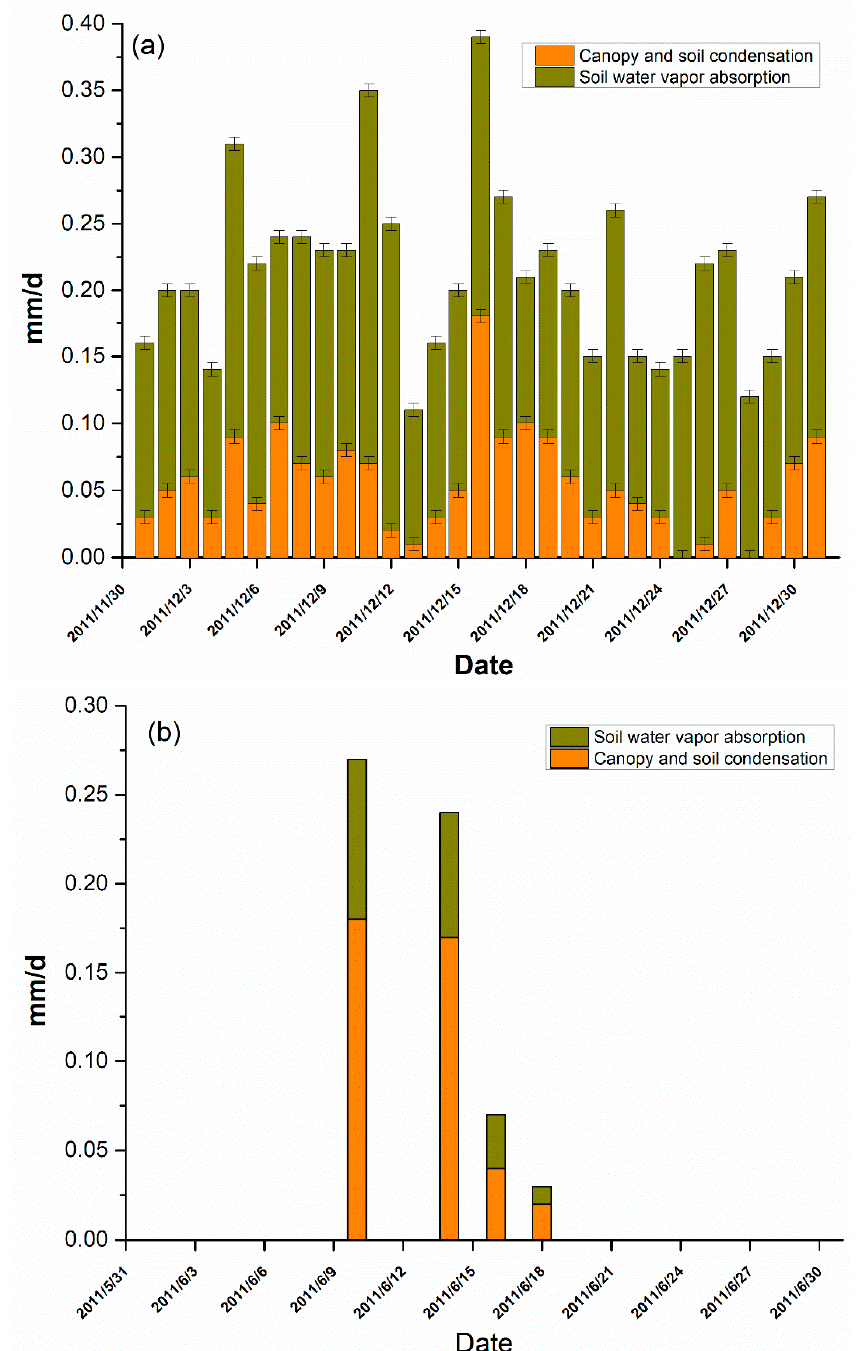
Figure 12. Quantitative variations among soil water vapor absorption and canopy and soil condensation on the basis of the measured soil water content at 0–5 cm, soil surface temperature, and calculated dew point temperature. Daily data was recorded from 1–30 June ( b ) and from 1–31 December ( a ).